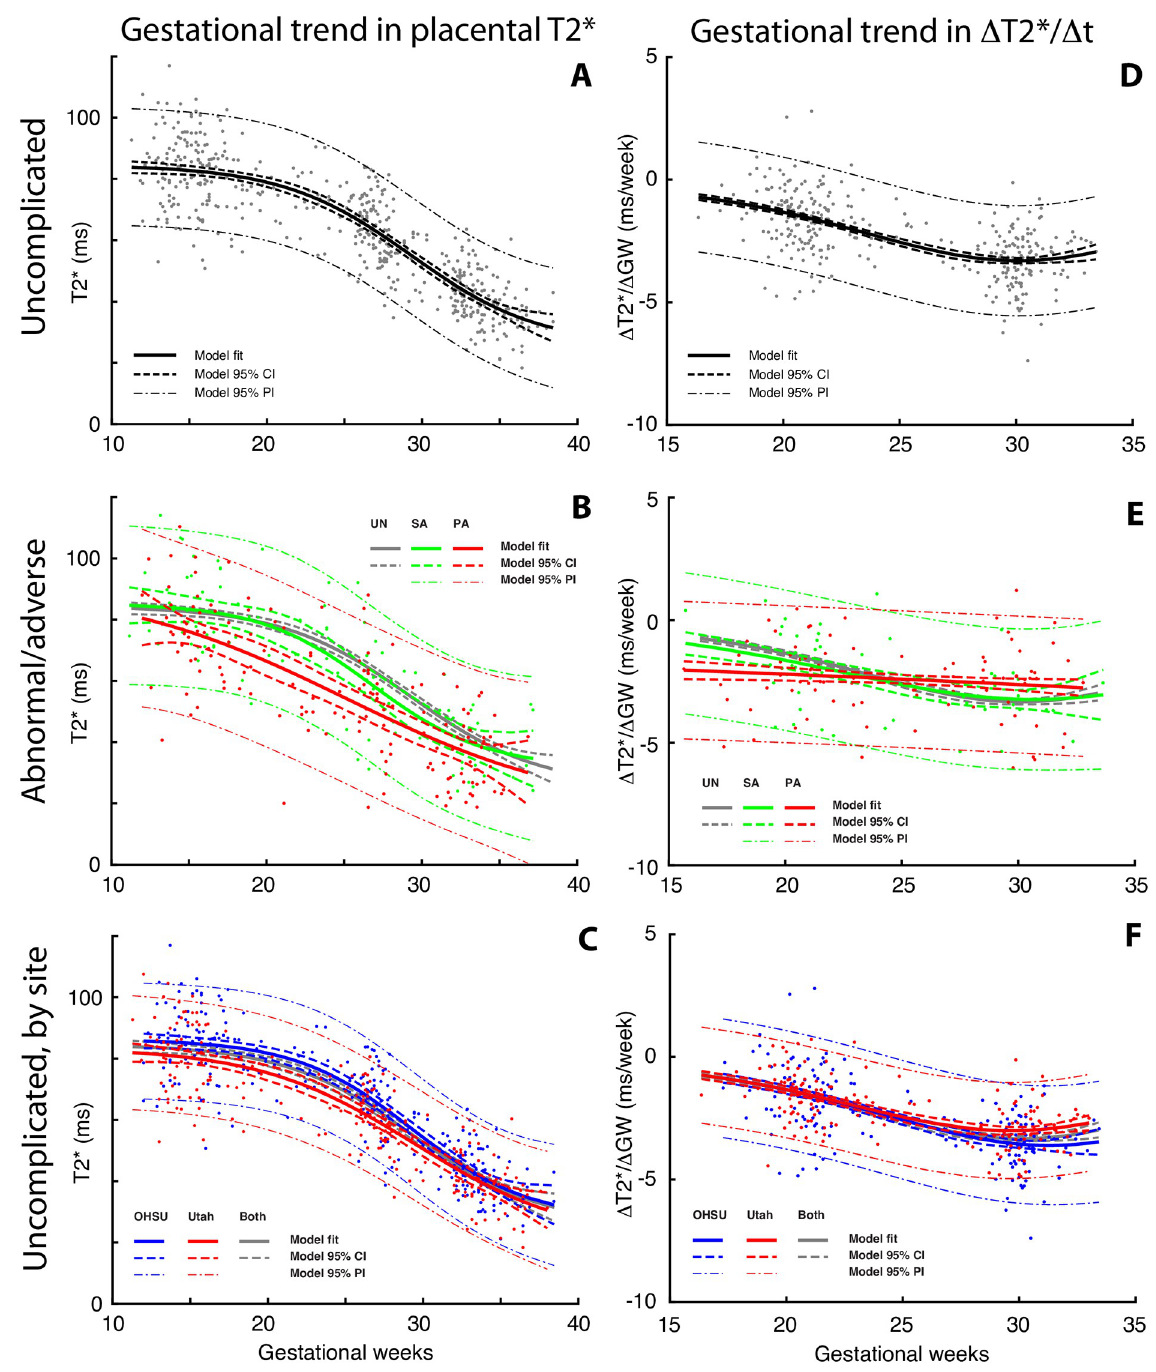
Fig 2. Gestational dependence of placental T2 � values and rates of change. Median T2 � values for each completed study, computed over the entire placenta, are plotted as a function of gestational age at time of imaging in the three panels in the left column (panels A, B, C). Rates of change in placental T2 � between repeated imaging time points within the same individual, where the x value is the mean gestational age of two sequential scans and the y value is the change in T2 � between the same two sequential scans, are plotted as a function of mean gestational age in the right column (panels D, E, F). The upper row plots these quantities for normal pregnancies, the middle row for abnormal (green) and adverse (red) pregnancies, and the bottom row for normal pregnancies stratified by site (OHSU in blue, Utah in red). In all graphs, model regression curves (using the functions and parameters given in Table 4) are indicated by the thick solid lines, the 95% confidence intervals by the dashed lines, and the 95% prediction intervals by the dot-dashed lines. The best fit and 95% CI curves from the UN population are superimposed in gray on the PA/SA and site-specific plots in the second and third rows for reference.